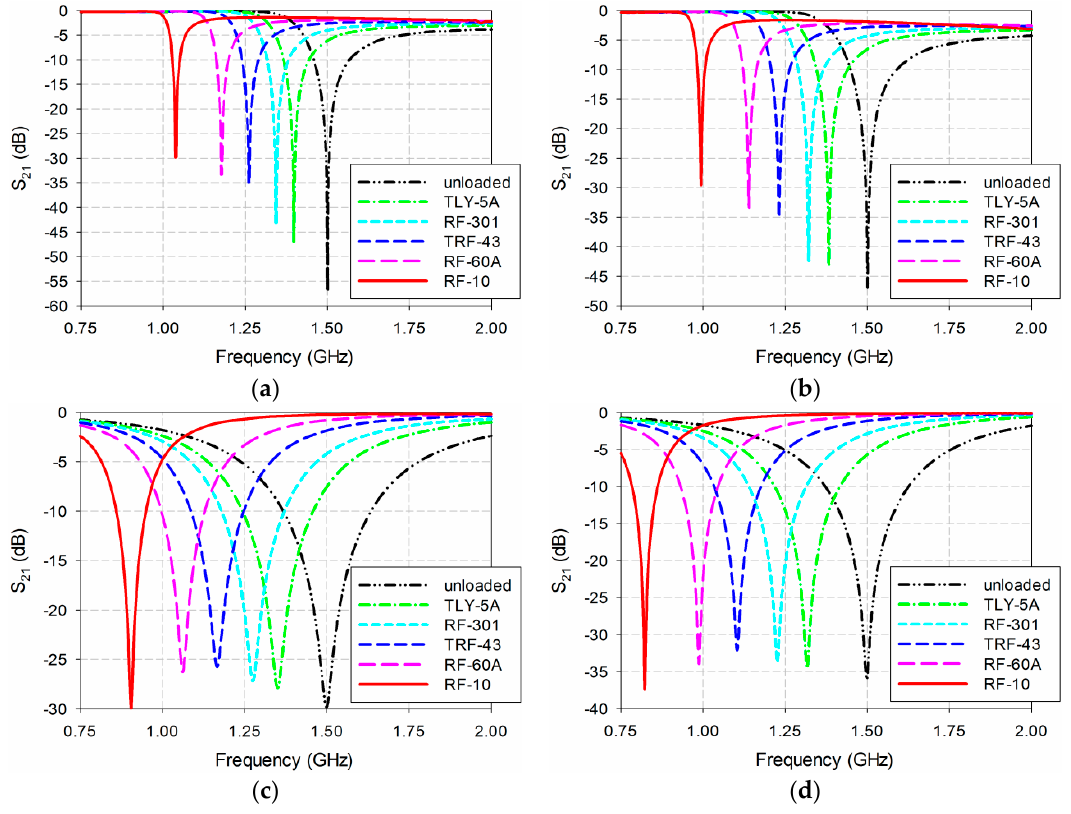
Figure 10. Simulated S 21 characteristics of the four permittivity sensors for MUTs in Table 2: ( a ) DR-CSRR; ( b ) SR-CSRR; ( c ) R-SR-CSRR; ( d ) proposed IDCS-DGS. Table 3. Simulated resonant frequencies of S 21 responses for the four permittivity sensors in GHz.